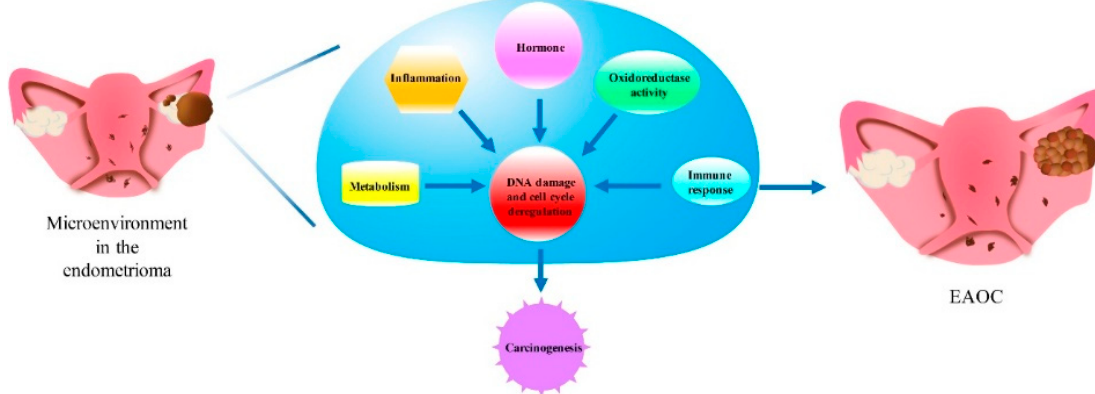
Figure 9. Possible contribution of the microenvironment in endometriosis to the development of EAOC. Endometriosis is an inflammatory condition arising from ectopic implantation of endometrial glands and stroma outside the uterine endometrium [29]. This microenvironment, especially the high concentration of free iron, which is derived from old menstrual blood accumulated in endometriosis (endometrioma), causes oxidative stress (ROS) and DNA damage [31,32]. Accumulation of DNA damage and inflammation/immune cytokines activated oncogenes [33,34]. Progressively reprogrammed metabolism and hormone changes over the years [35–37] eventually lead to the carcinogenesis of EAOC.